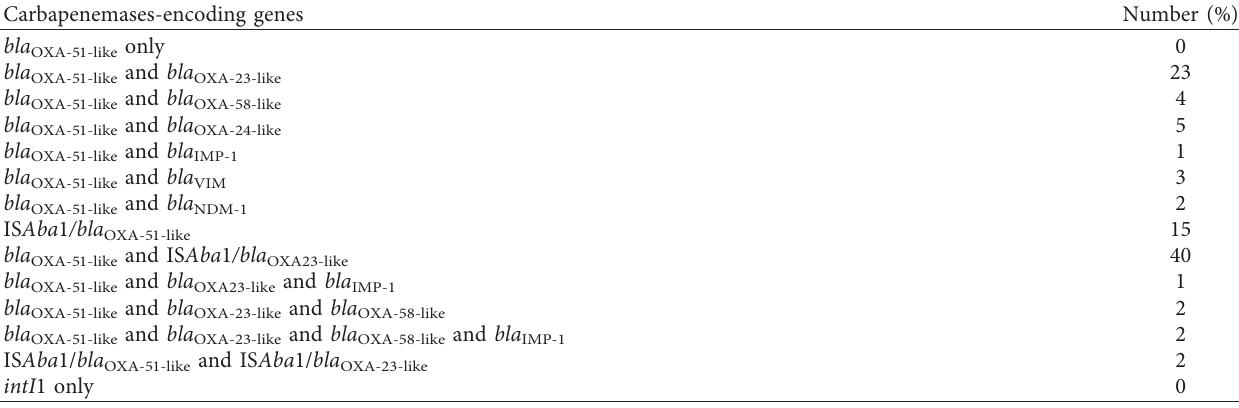
Table 3: Percentage distribution of carbapenemases-encoding genes in 100 CRAB